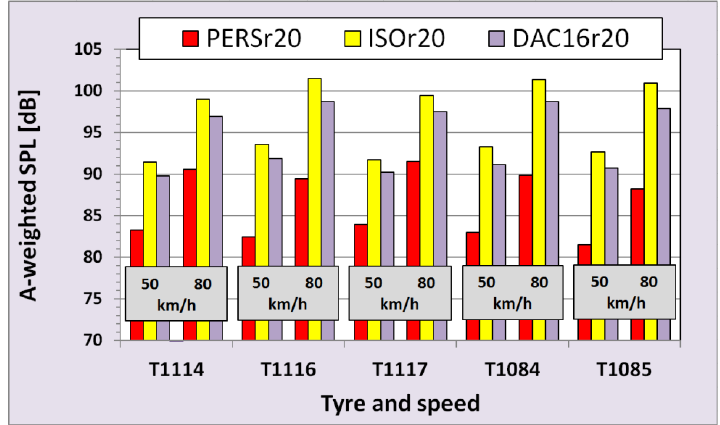
Figure 3. A ‐ weighted SPL for truck tires (PERS is the PERS ‐ HET ‐ type).